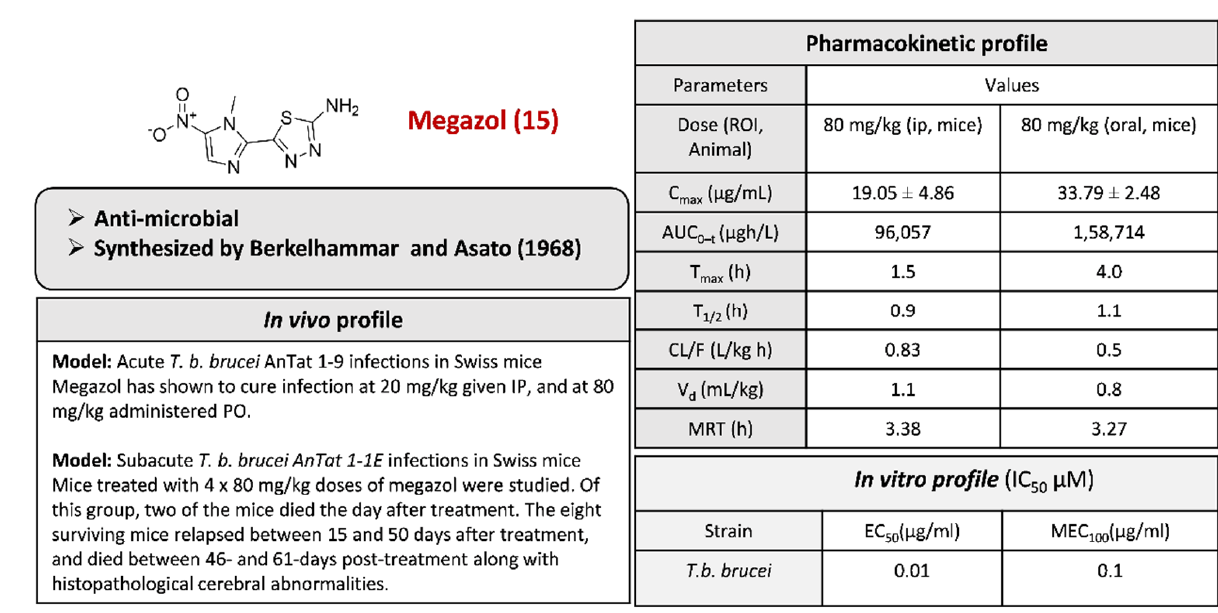
an EC 50 of 0.01 µ g/mL and was found to be effective in curing the acute disease condition (Figure 19) [144]. Megazol 15 has good oral exposure with the highest AUC and C max values when compared to the intraperitoneal route [145].